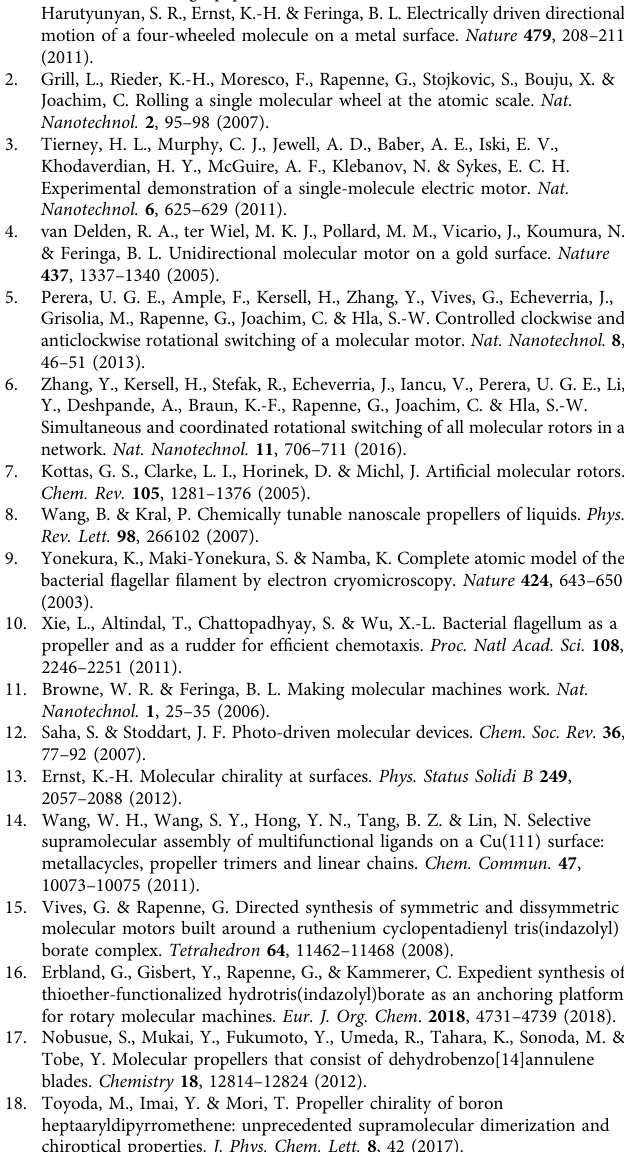
Fig. 5 Propeller rotation by mechanical manipulation. a A drawing depicting the mechanical rotation. b Mechanical manipulation signals during a single step rotation of M and P propellers. Inset: The arrows indicate the path and direction of manipulations. The top manipulation signal is vertically displaced 1.5 Å for clarity. c The mechanical rotation process. The dashed circles indicate the propeller bottom and the position of a phenyl ring underneath. d STM image before and e after a single propeller blade rotation. White arrow in d indicates the manipulation direction [Imaging parameters: V t = − 0.1 V, I t = 50 pA]. f An initial STM image of a left-handed molecular propeller. g and h After single step rotations into clockwise direction. i STM image of a right-handed propeller and j and k are after stepwise rotations into anticlockwise directions. [Imaging parameters: V t = − 0.1 V, I t = 50 pA] l and m Rotation angle as a function of count for the forward and reverse rotations,